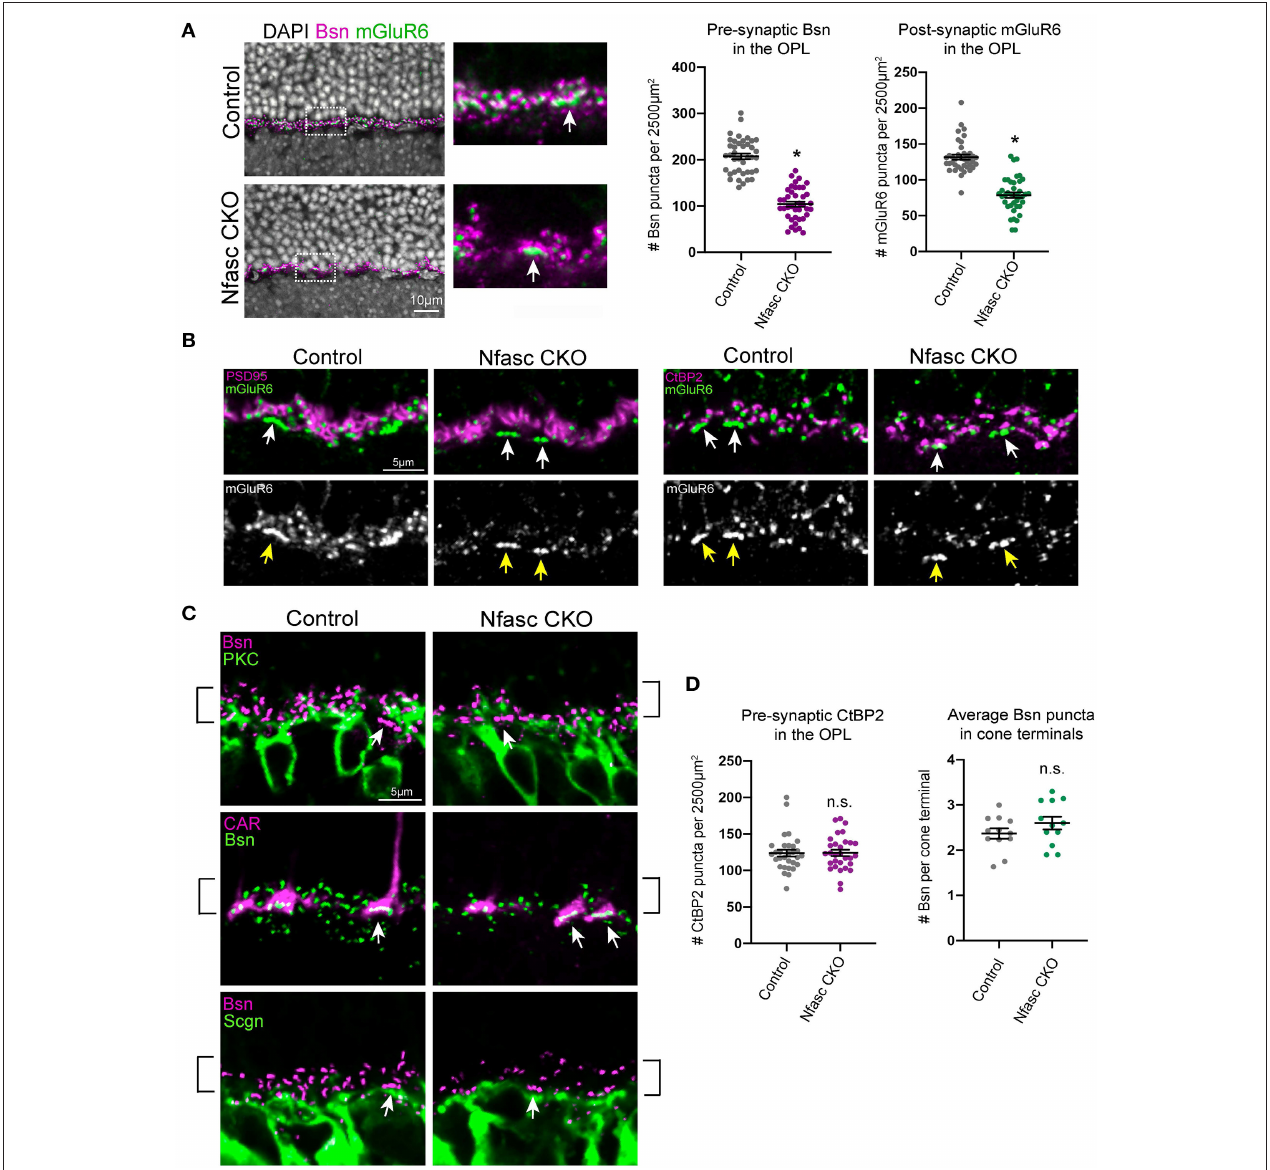
FIGURE 3 | Selective reduction of pre- and post-synaptic protein expression in Nfasc CKO (A–D) . Pre-synaptic Bassoon (magenta) and post-synaptic mGluR6 (green) protein is significantly reduced in Nfasc CKO compared to controls (A) . Insets are zoomed images of dotted boxed region. At P30, Bsn and mGluR6 forms a puncta-like structure with 0.6 and 1.0 µ m in size, respectively. Number of Bsn and mGluR6 puncta were counted in the OPL with an area of ∼ 2,500 µ m 2 . A total of 10 different confocal sections were analyzed from four control animals ( n = 40) and four Nfasc CKO animals ( n = 40). Data are represented as mean values ± SEM. Statistical significance was determined using an unpaired t -test. * p < 0.0001. Images are shown as a single confocal section. Scale bar, 10 µ m (A) . Rod terminals appear to be normally positioned in the OPL in Nfasc CKO (B) . Staining with anti-PSD-95 (magenta) and anti-CtBP2 (magenta) shows expression is not affected even in areas where mGluR6 expression is reduced (green, white). Cone terminals appear to be unaffected as denoted by white and yellow arrows (B) . Dendrites of rod bipolars (anti-PKC, green) and cone bipolars (anti-Scgn, green) are localized to the OPL in both Nfasc CKO and control retinas. Bsn puncta (magenta, green) appears to be reduced in the rod synaptic layer as outlined by black brackets and not in the cone synaptic layer as seen with anti-CAR (magenta) and depicted with white arrows (C) . Quantification of CtBP2 puncta within the OPL shows no statistical difference between Nfasc CKO and controls. The average number of Bsn puncta per cone terminal within a confocal section are plotted. These measurements were taken from 12 different retinal sections from four control and four Nfasc CKO mice. A total of 118 cone terminals were analyzed for controls and 101 for Nfasc CKO (D) .